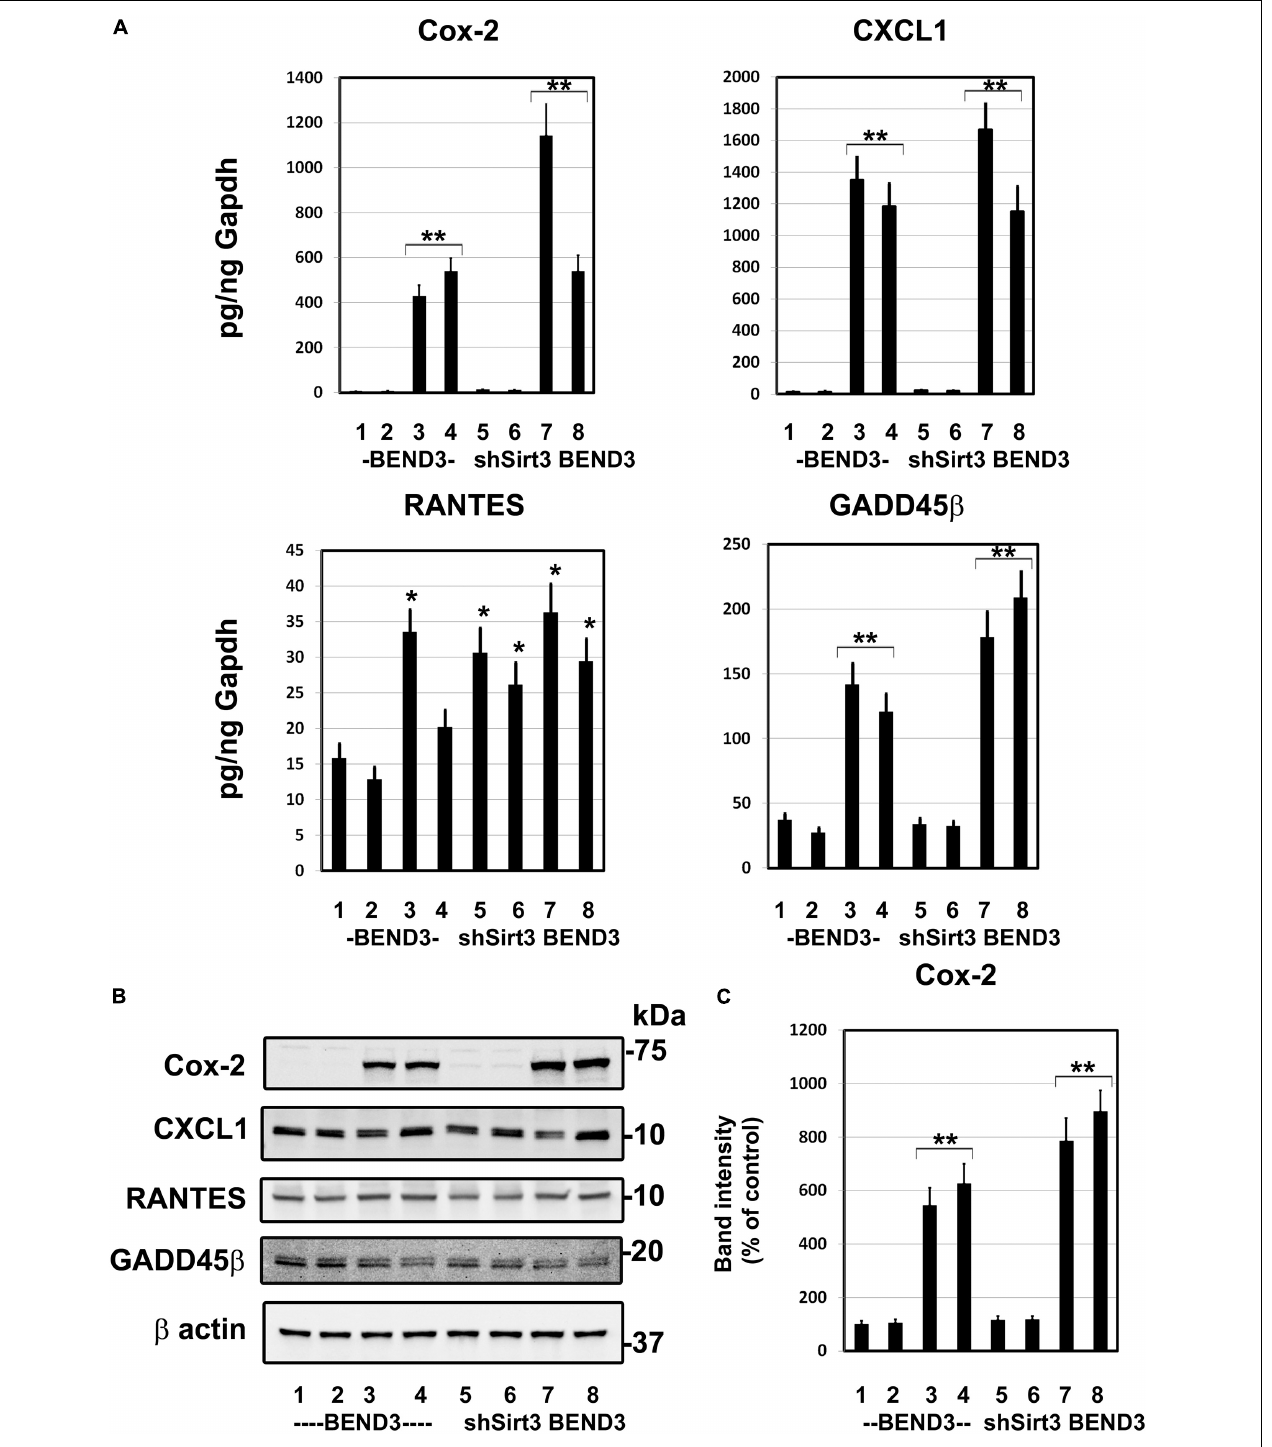
FIGURE 4 | Induction of inflammatory genes in endothelial cells exposed to glucolipotoxicity. (A) BEND3 and shSirt3- BEND3 cells were cultured in the absence (1) or presence of 30 mM glucose (2), 300 µ M palmitic acid (3) or combination of both (4) for 48 h. The cells were processed for RNA isolation and RT-PCR analysis of Cox-2, CXCL1, RANTES, and GADD45 β . mRNA levels of chemokines were expressed in attograms (ag) per pg of GAPDH. (B) BEND3 and shSirt3-BEND3 cells were cultured in the absence (1) or presence of 30 mM glucose (2), 300 µ M palmitic acid (3) or combination of both (4) for 48 h. The cell lysates were prepared and immunoblotted for Cox-2, CXCL1, RANTES and GADD45 β . The blots were re-probed for β -actin. (C) The bands for Cox-2 were scanned and corrected for the levels of β -actin. *, P < 0.01; **, P < 0.001 vs untreated controls. shSirt3, Sirt3-silenced.